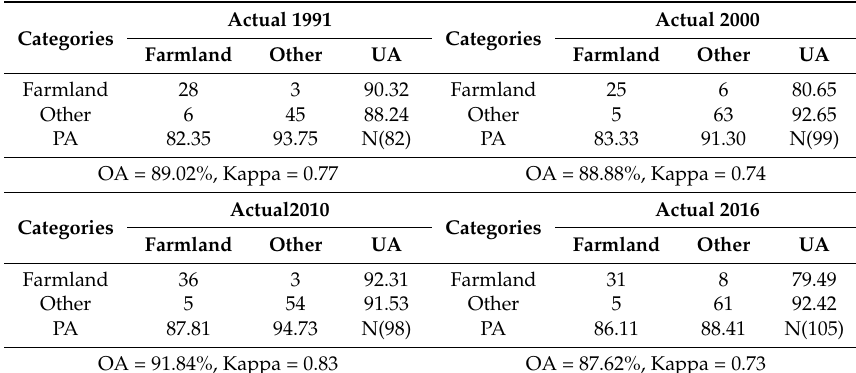
Table 3. Accuracy assessment of the classification results.